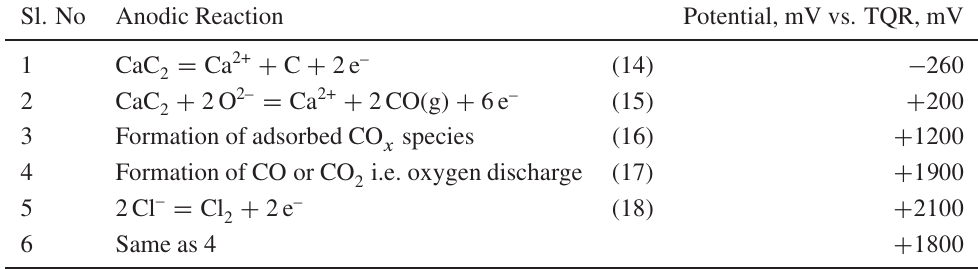
Table 4. Reactions taking place at the anode during electrochemical reduction of TiO